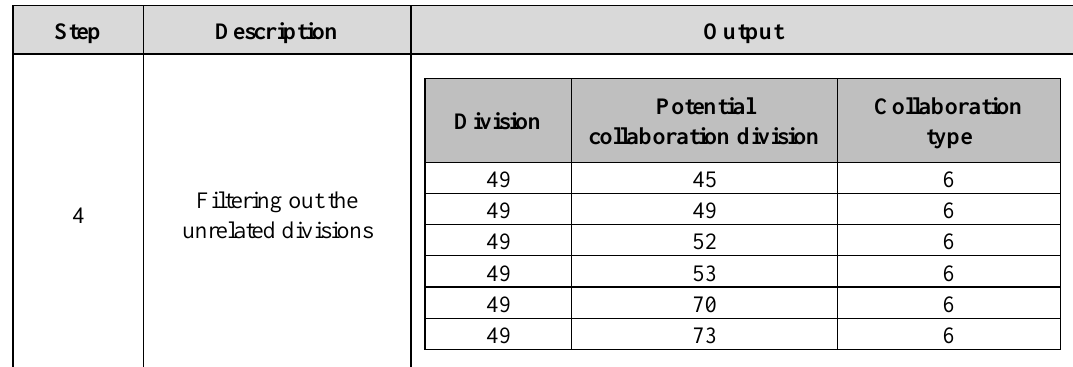
Table 10. Step 4/5 of detecting collaboration